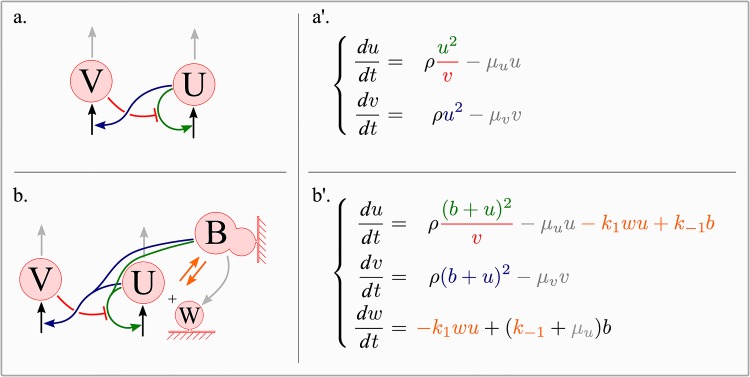
The derivation of the extended Gierer-Meinhardt model.Kinetic scheme for the classical (a) and the extended (b) GM models are presented on the left side; the corresponding equations are on the right. Arrows indicating interactions between reactants have the same color as the reaction terms in corresponding equations: green for autocatalytic terms, red for inhibition of activator by inhibitor, gray for degradation terms and orange for the adsorption and the desorption terms.